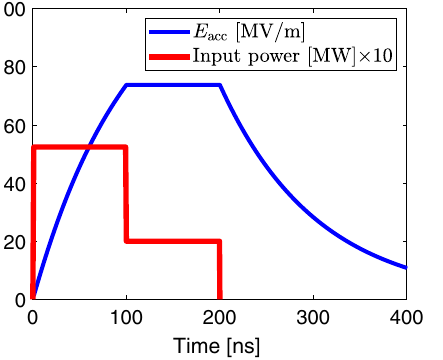
FIG. 11. 200 ns step-pulse input pulse and the E the structure (THU-CHK-#1).